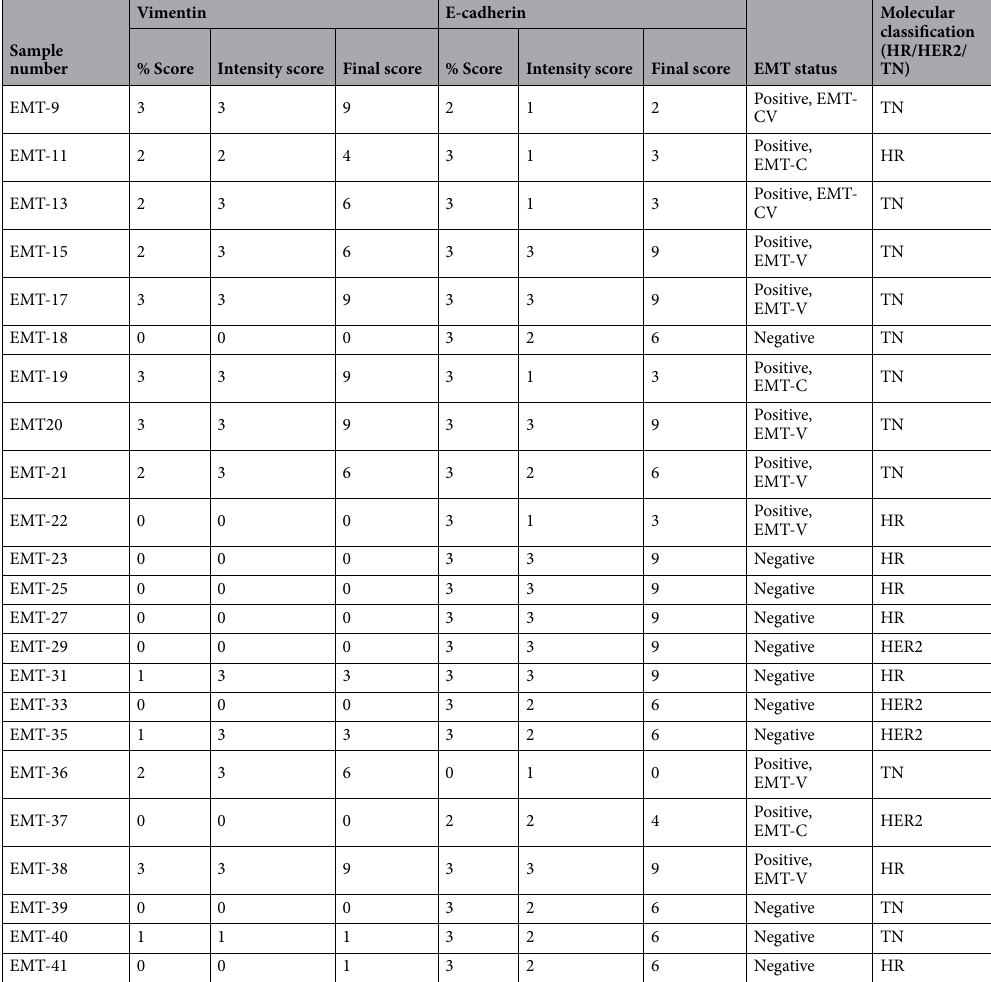
Table 2. EMT scores and molecular classification of breast cancer